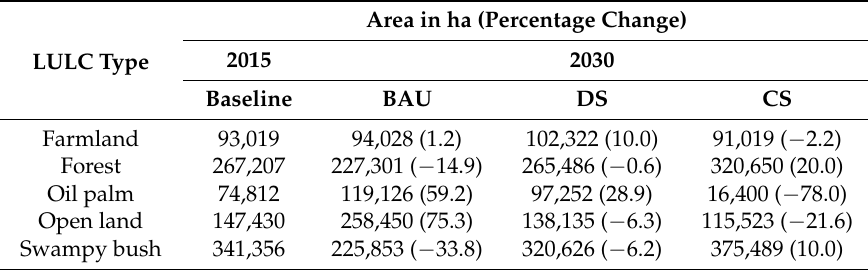
Figure 3. Land use and land cover (LULC) under different scenarios. Table 1. Area change according to land use and land cover (LULC) type.